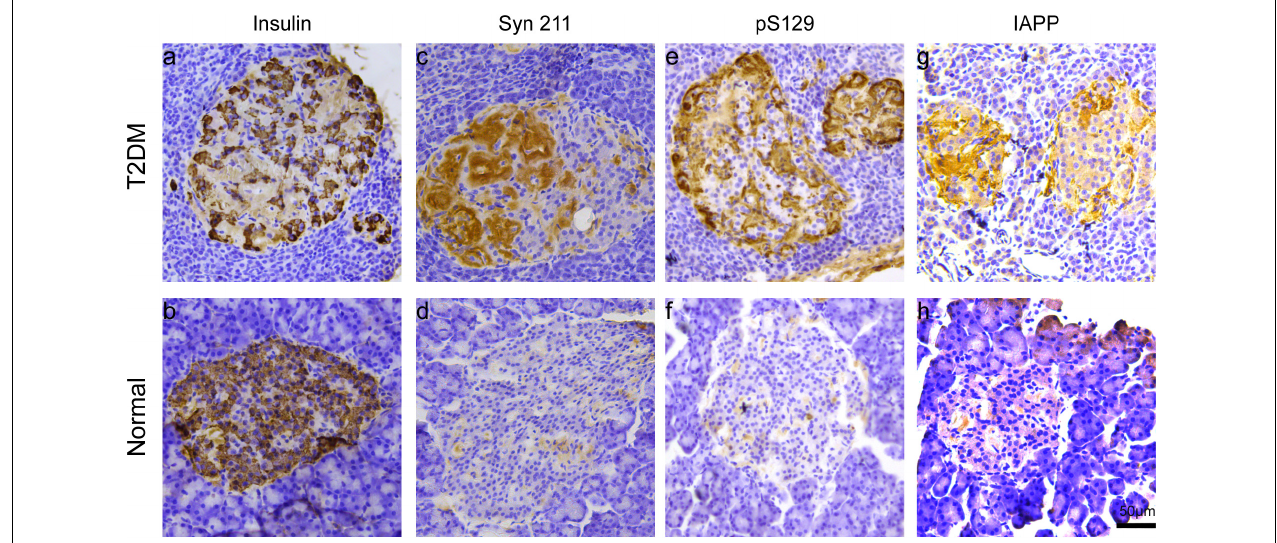
FIGURE 2 | Microscopic images of insulin, α -synuclein, phosphorylated α -synuclein, and IAPP in the pancreatic islets. Immunohistochemical stainings with antibodies specifically against insulin (a,b) , α -synuclein (Syn 211) (c,d) , phosphorylated α -synuclein (pS129) (e,f) , and IAPP (g,h) in a 20-year-old female T2DM monkey (ID: DM952044) (a,c,e,g) and in a 21-year-old normal female monkey (ID: N930840) (b,d,f,h) . Scale bar = 50 µ